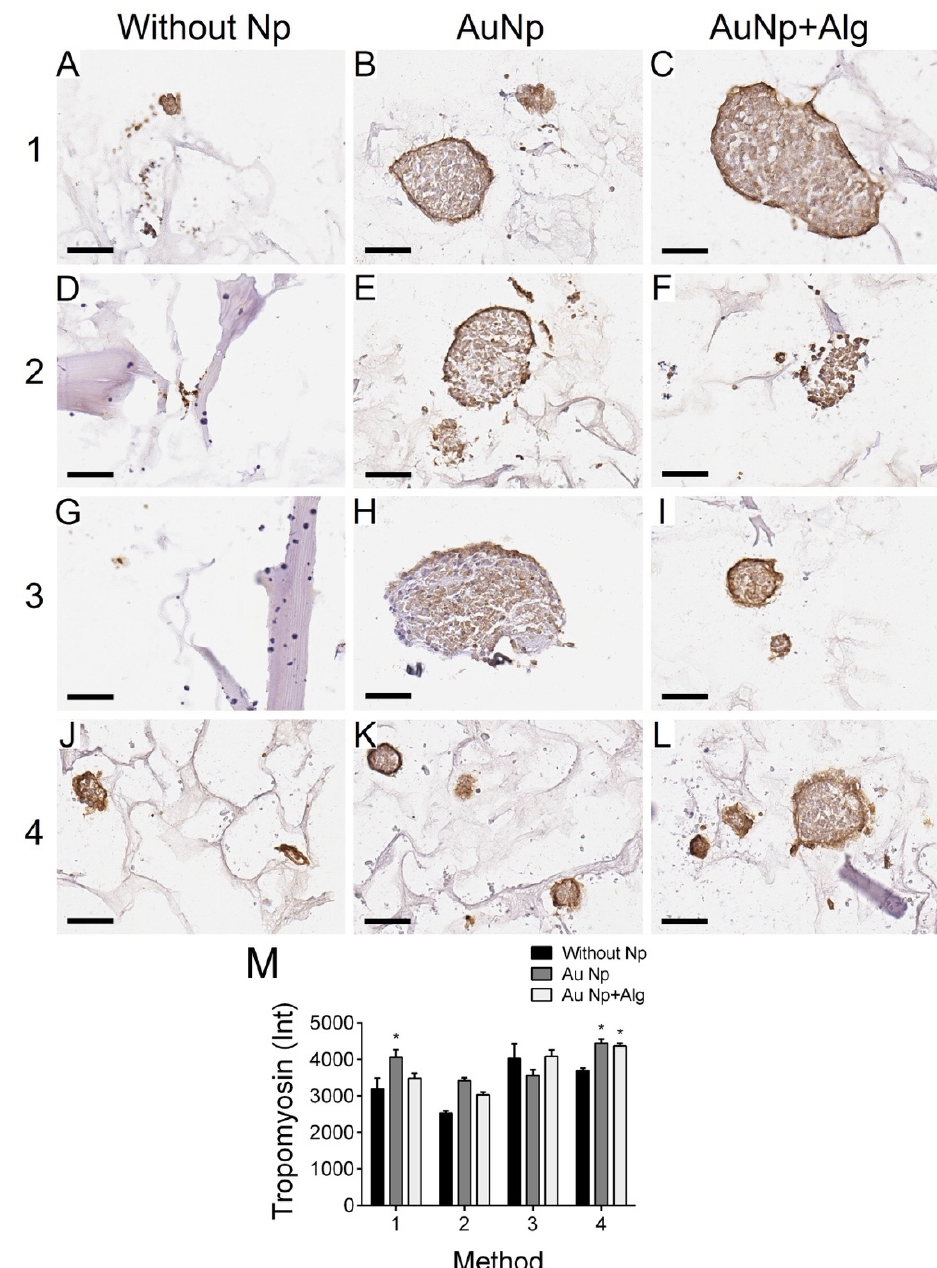
Figure 8. Representative photomicrographs of tropomyosin expression in different constructs. Method 1: ( A ) without Np, ( B ) AuNp and ( C ) AuNp+Alg. Method 2: ( D ) without Np, ( E ) AuNp and ( F ) AuNp+Alg. Method 3: ( G ) without Np, ( H ) AuNp and ( I ) AuNp+Alg. Method 4: ( J ) without Np, ( K ) AuNp and ( L ) AuNp+Alg. Scale bar: 50 µ m, original magnification: × 400. ( M ) Graphical representation of the quantitative analysis of tropomyosin expression (Int) in the different constructs. (*) p < 0.001. Data are presented as the mean ±